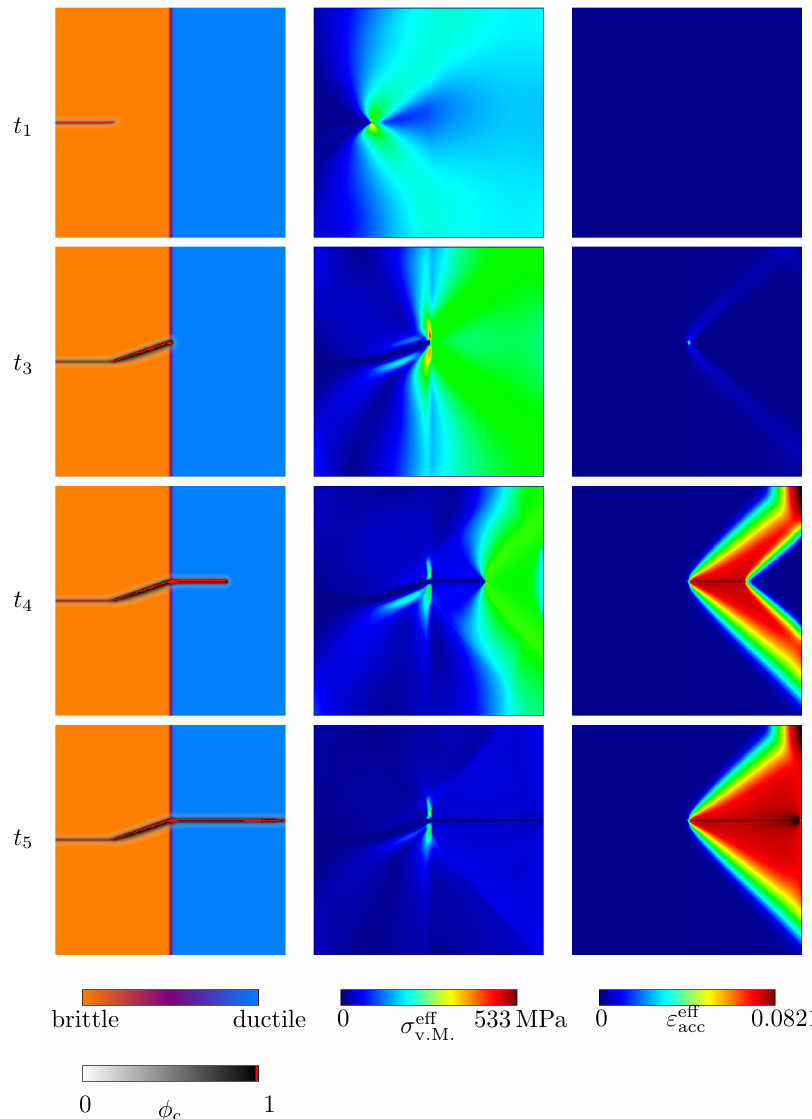
Figure 3. Contour plots of the evolution of the crack phase field φ c (first column) and the resulting von Mises stresses σ eff (second column), together with the effective accumulated plastic strain ε eff acc v.M. (third column) for the simulation setup with a planar diffuse interface between two solid phases for the set of standard parameters, Equation (32). The corresponding macroscopic uniaxial strain states are given in Figure